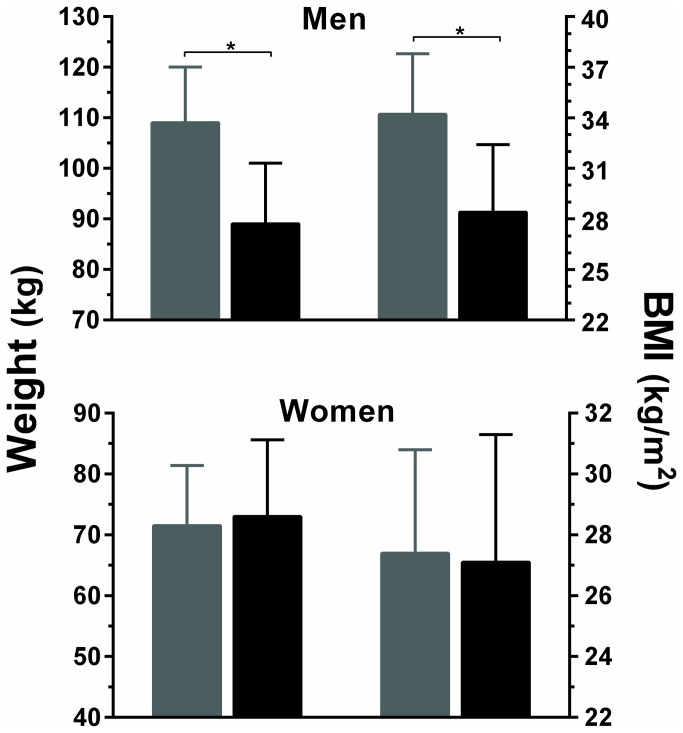
Weight and BMI in men and women (F1) who were born preterm (gray) or at term (black).Data are means and 95% confidence intervals adjusted for other confounding factors in the multivariate models.